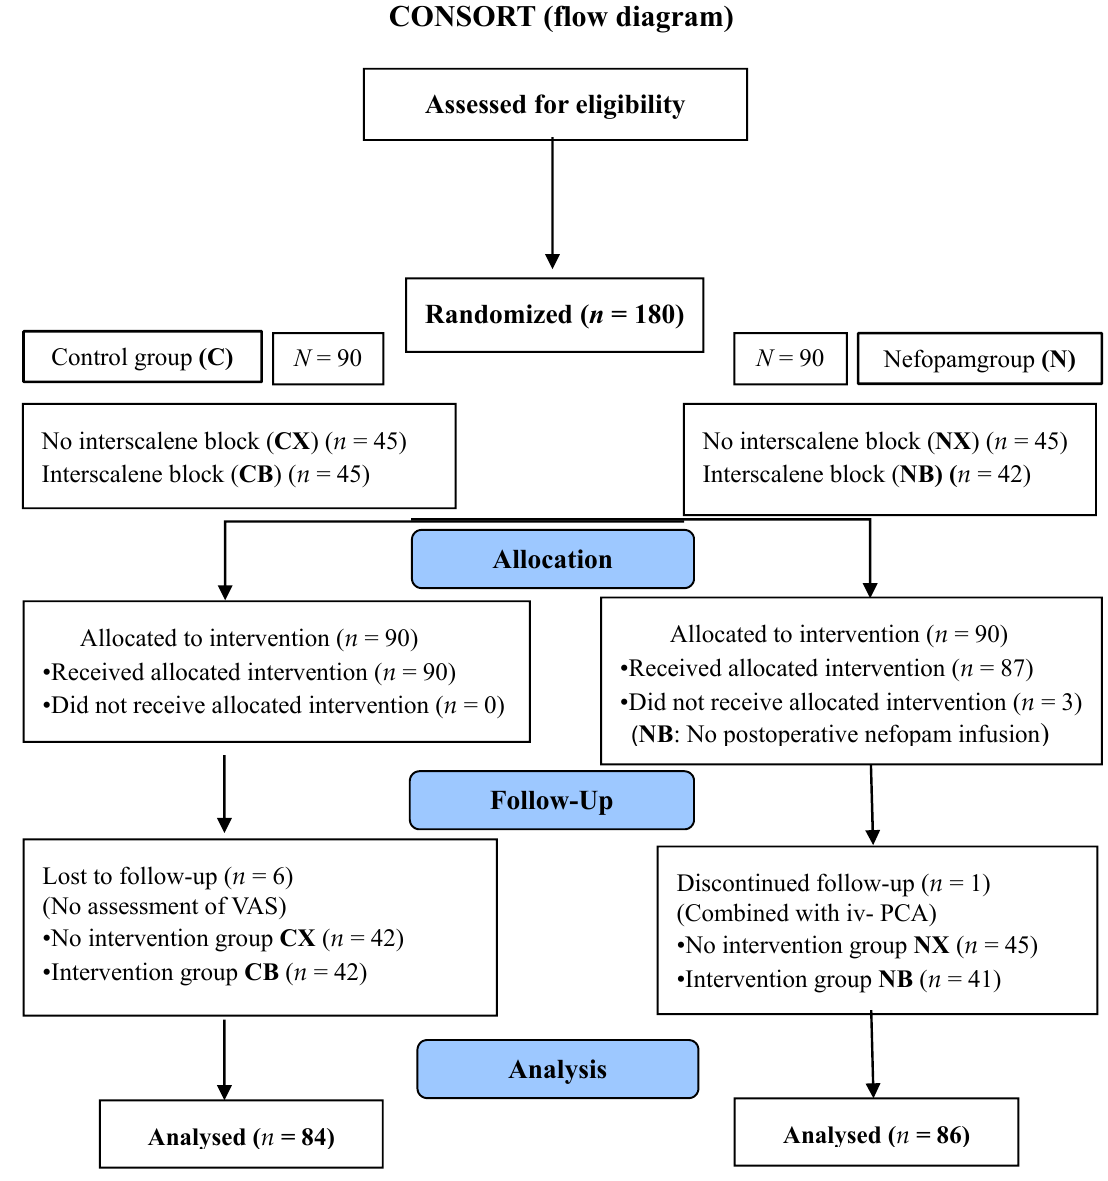
Figure 1. Flow diagram. N: groups administered nefopam, NX: only nefopam, NB: nefopam with ISB, CX: without nefopam and ISB, CB: ISB without